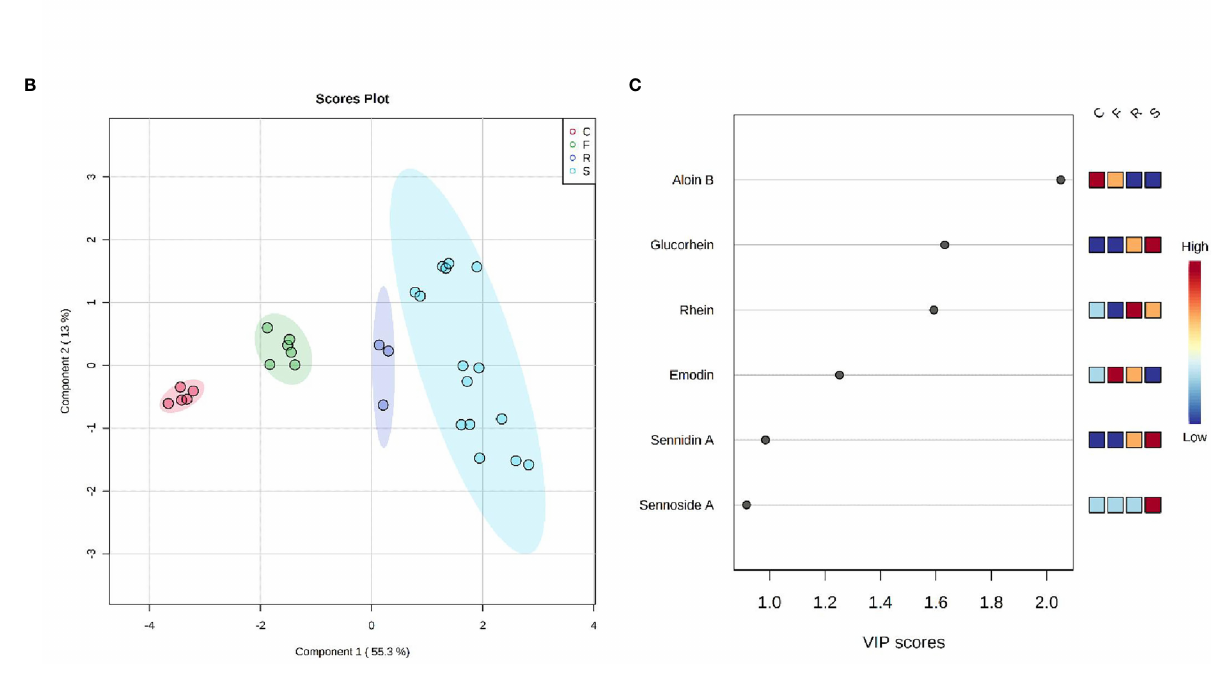
FIGURE 6 (A) Heatmap of HAD matrix, every row indicates a compound, every column a sample (C, Cascara - Rhamnus purshiana ; F, Frangula - Rhamnus frangula ; R, Rhubarb - Rheum palmatum ; S, Senna - Cassia angustifolia ). Red indicates high abundance, and light blue low abundance. (B) PLS-DA with four clusters of samples in different colors: red for C (Cascara - Rhamnus purshiana ), green for F (Frangula - Rhamnus frangula ), blue for R (Rhubarb - Rheum palmatum ), and light-blue for S (Senna - Cassia angustifolia ). (C) VIP score plot with the list of the most important metabolites allowing discrimination between samples (C, Cascara - Rhamnus purshiana ; F, Frangula - Rhamnus frangula ; R, Rhubarb - Rheum palmatum; S, Senna - Cassia angustifolia